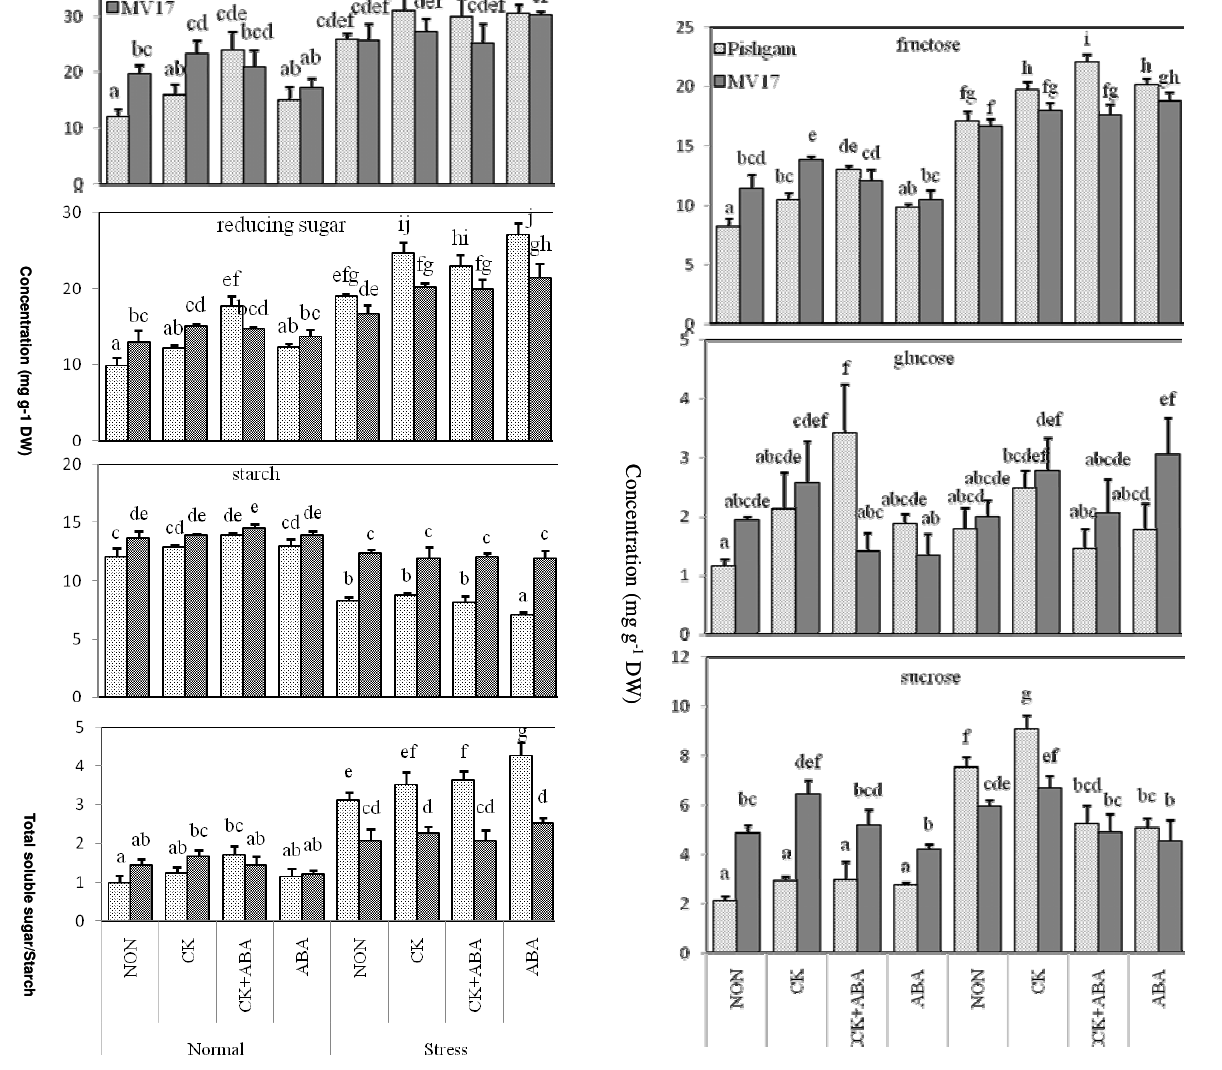
Fig. 1. Effect of hormonal treatments of CK, ABA and CK/ABA on total soluble sugar, reducing sugar, starch content and total soluble sugar/starch ratio under irrigation and drought condition in flag leaves during grain filling in two wheat cultivars (drought tolerant cv. ‘ Pishgam ’ (white columns) and drought sensitive cv. ‘ MV-17 ’ (black columns). Data are shown as mean ± SD of three independent measurements